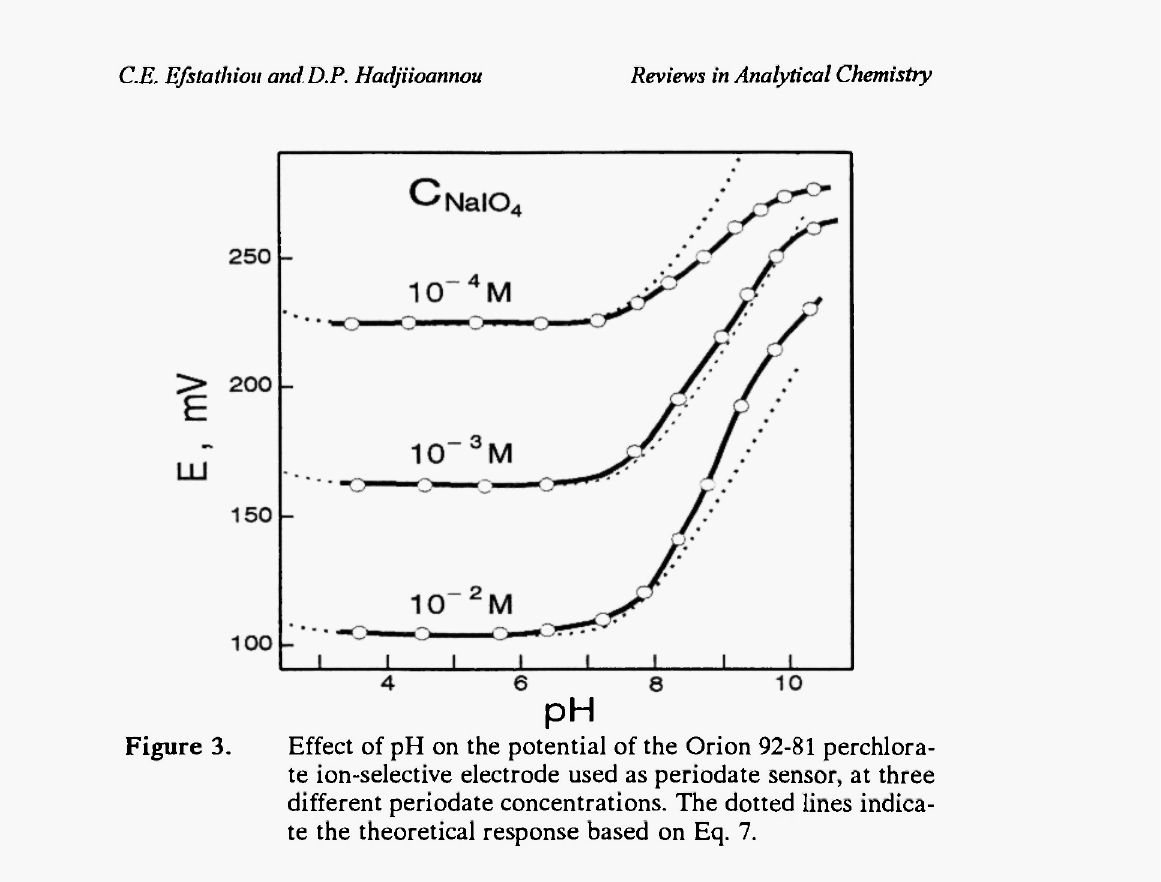
Figure 3. Effect of pH on the potential of the Orion 92-81 Perchlora- te ion-selective electrode used as periodate sensor, at three different periodate concentrations. The dotted lines indica- te the theoretical response based on Eq.